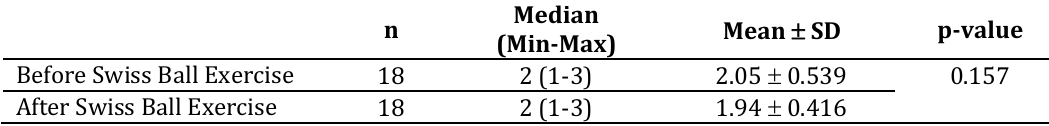
Wilcoxon Test Results with Berg Balance Scale in Control Group